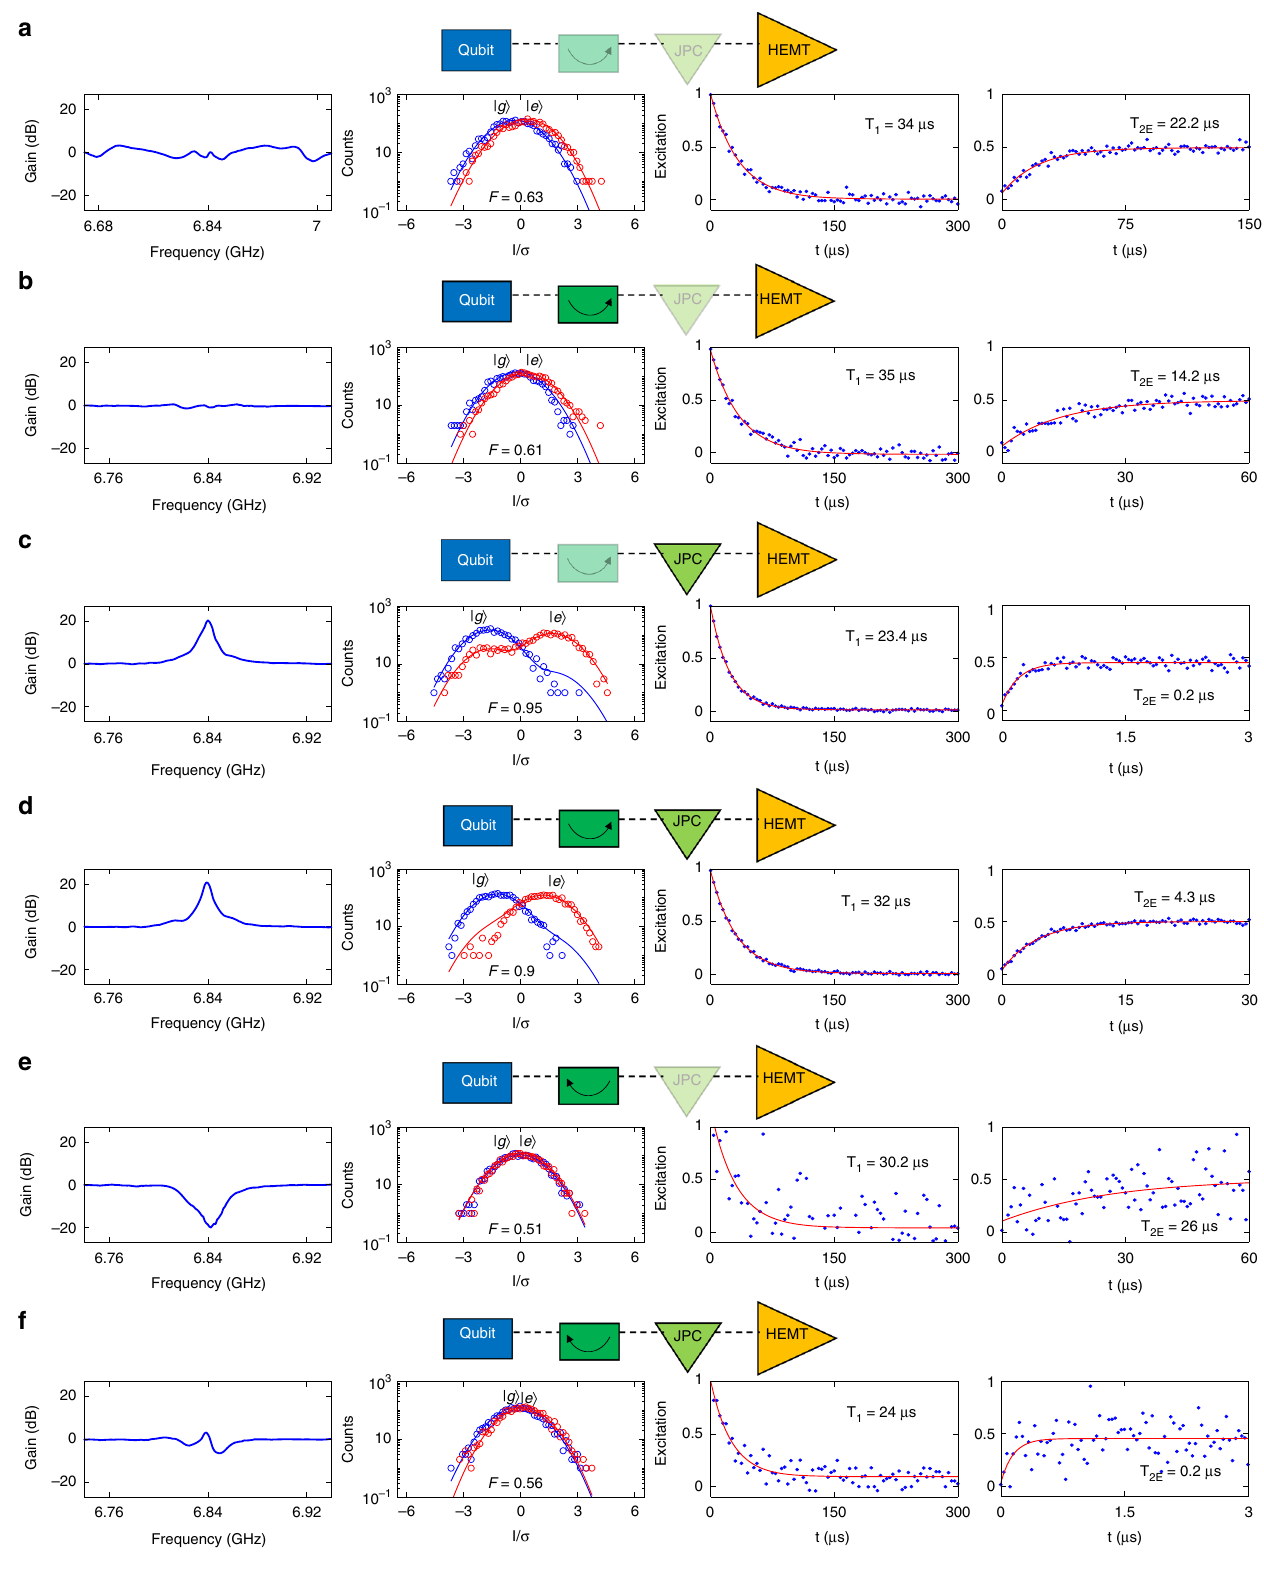
isolator (i.e., con fi guration b ). Finally, in con fi guration f , in which the JPC is ON, the ampli fi cation of the JPC almost cancels the to a slight enhancement of the readout fi delity F = 0.56.